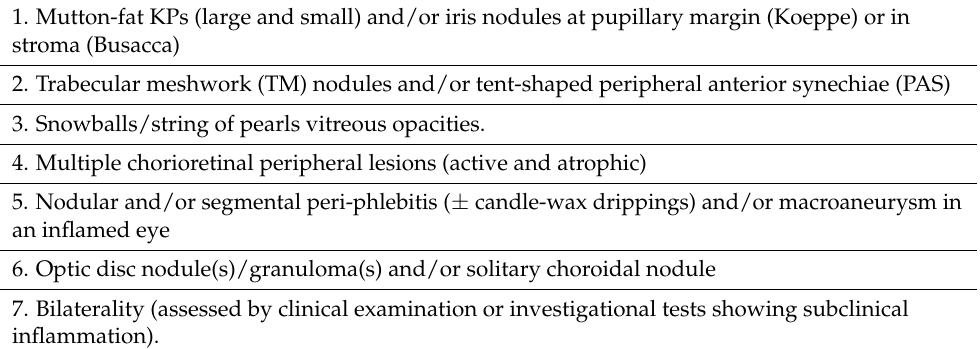
Table 7. List of IWOS clinical signs suggestive of ocular sarcoidosis